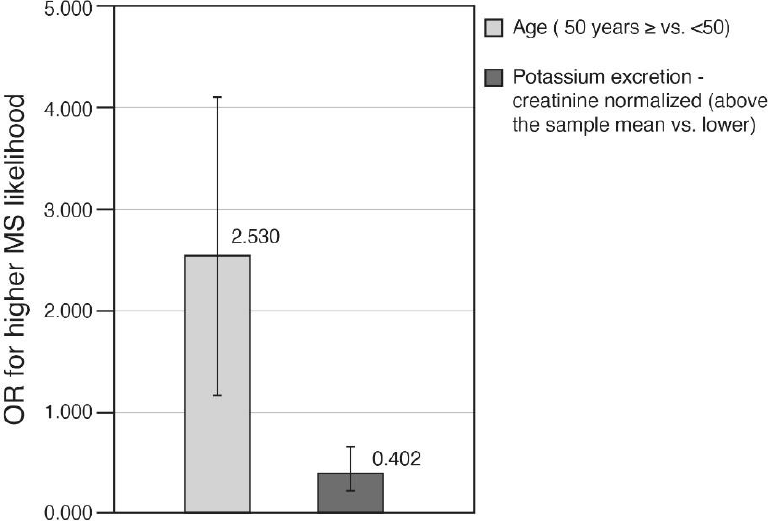
Figure 4. Adjusted Odds Ratios for high MS likelihood explained by potassium excretion and other explanatory variables. ORs using stepwise logistic regression predicting MS likelihood (=1 as compared to lower likelihood, =0) by potassium excretion (normalized to creatinine levels) –adjusted to the potential confounders: age ( ≥ 50 vs. <50 years), sex (0—female, 1—male), physical activity (at least 20 min/wk.: 0—no, 1—yes) and caloric intake (Kcals). Caloric intake was entered excluding outliers ( n = 25) (as mentioned in the methods section). Only significant variables are presented by the bars; error bars represent 95% confidence intervals. Model summary by Nagelkerke R Square, 8.5%. Abbreviations: MS, Metabolic syndrome; OR, Odds Ratio.